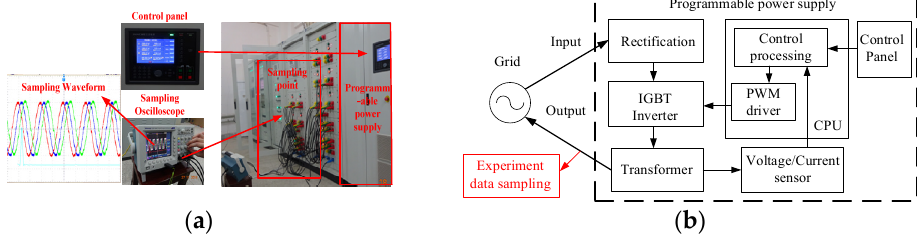
Figure 11. Experiment platform and Schematic diagram. ( a ) Experiment platform. ( b ) Schematic diagram of the programmable power supply.